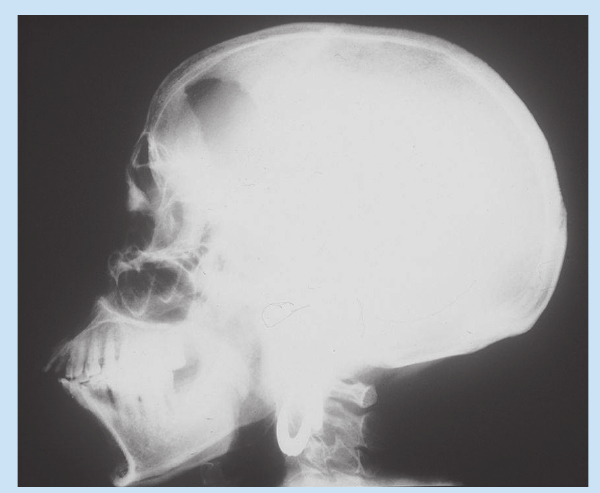
Fig. 1. Lateral skull X-ray: a right frontal bone